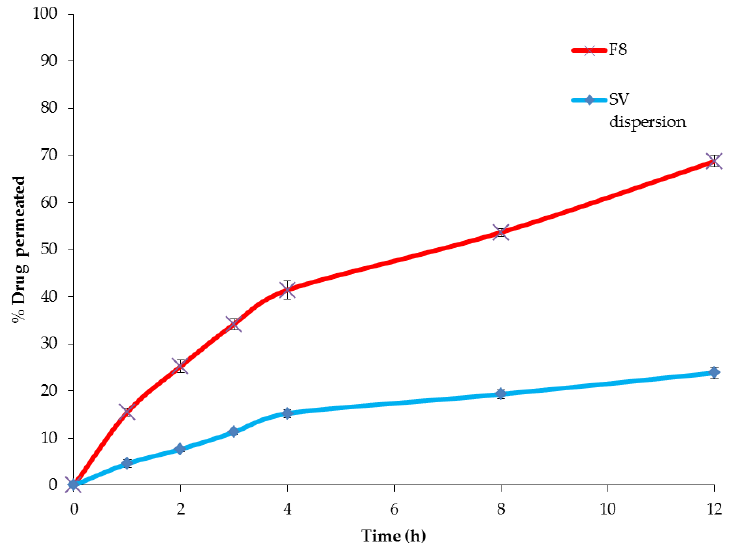
Figure 10. Ex vivo permeation profile of SV aqueous dispersion and the optimized SV-loaded SNVs (F8) through rat skin for 12 h, ( n = 3). Abbreviations: SV, Sodium valproate; SNVs, spanlastic nanovesicles. Table 4. Ex vivo permeation parameters of the optimized SV-loaded SNVs and SV aqueous dispersion.